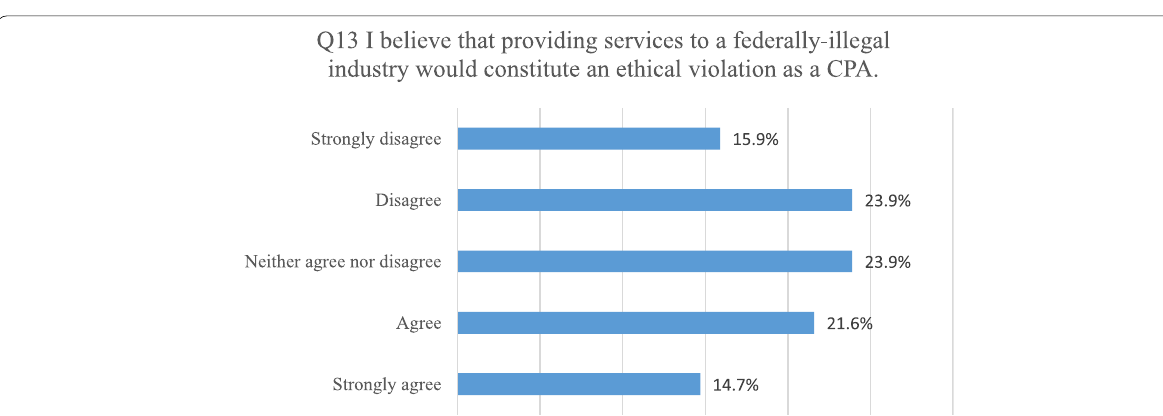
Fig. 10 Indication of CPAs’ agreement with the survey statement “I believe that providing services to a federally illegal industry would constitute an ethical violation as a